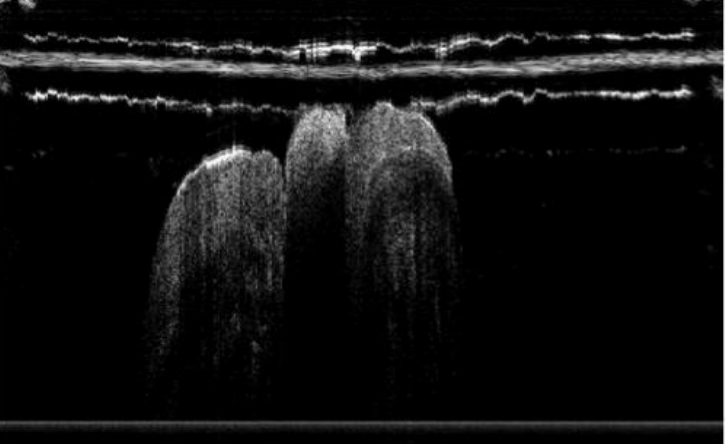
Figure 7. In vivo OCT image of microleakage detected by a custom-made dental optical probe (reprinted from reference [55]).